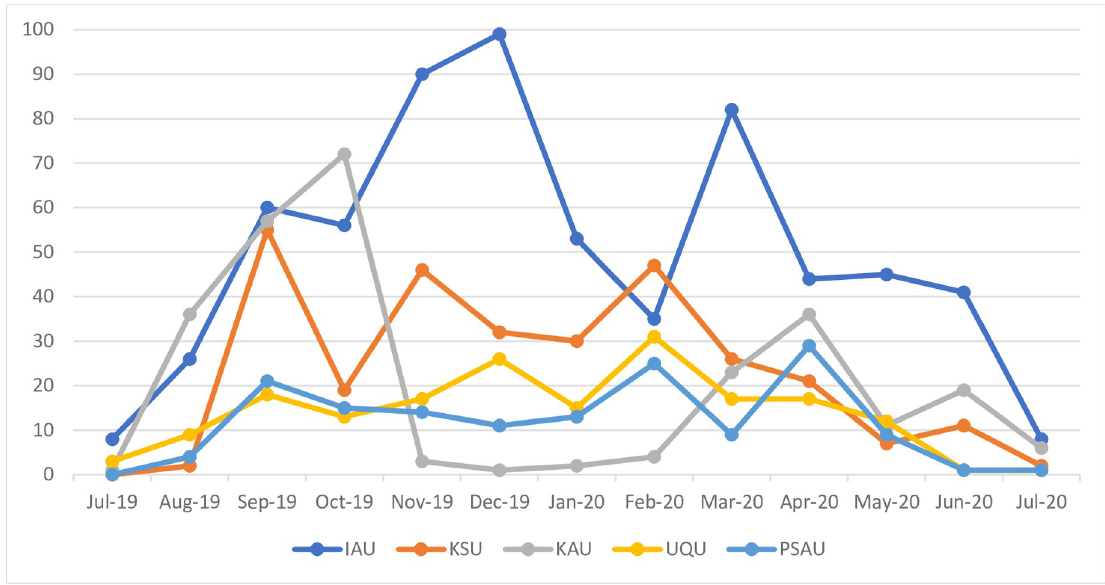
Fig 2. Time distribution of tweets for top five dental schools from July 2019 to July 2020. IAU: Imam Abdulrahman Bin Faisal University, KSU: King Saud University, KAU: King Abdulaziz University, UQU: Umm Al-Qura University, PSAU: Prince Sattam Bin Abdulaziz